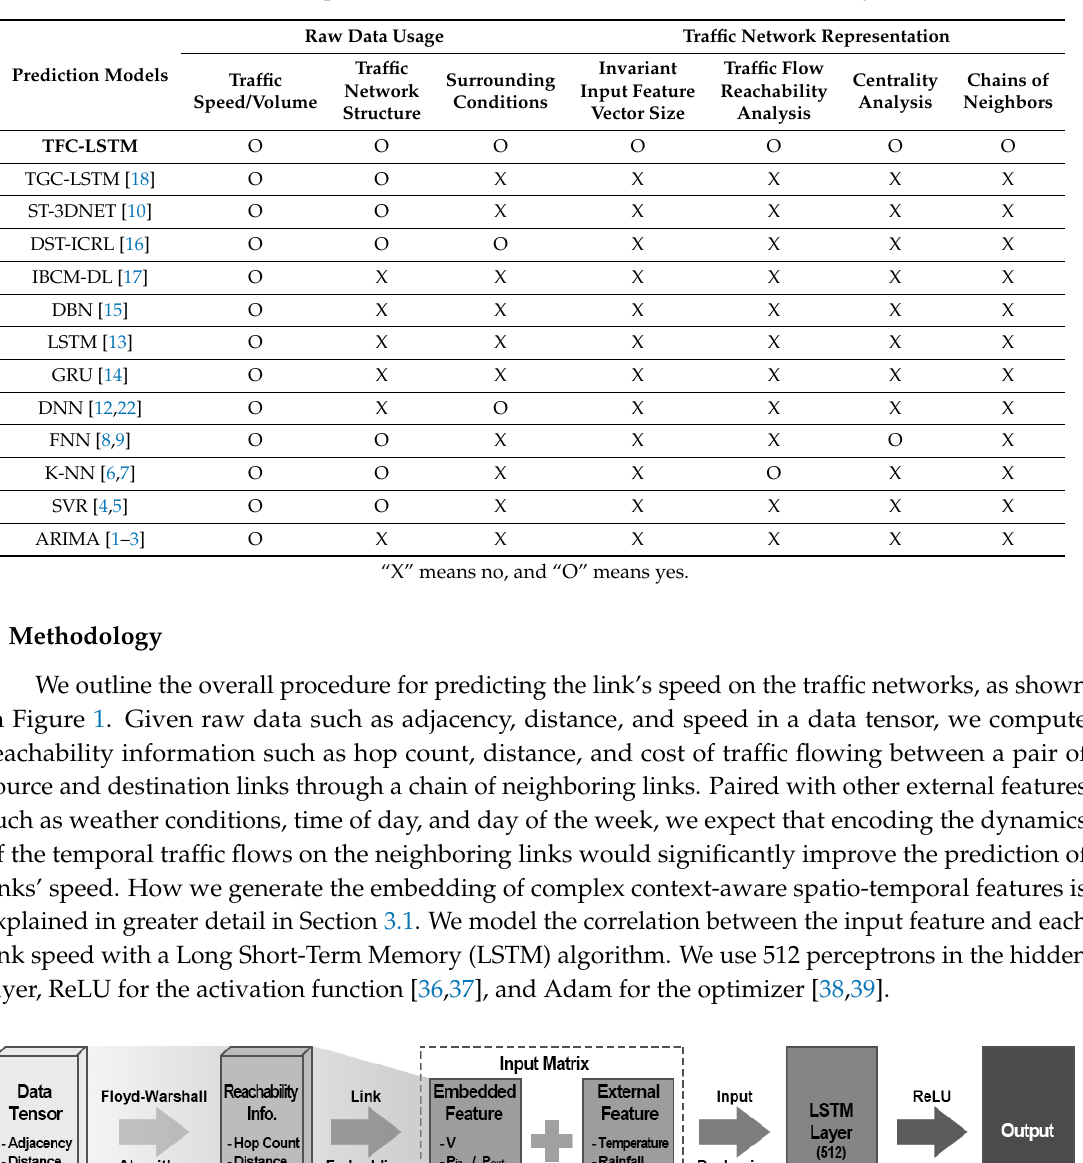
Table 1. Comparison with other models. TFC, Traffic Flow Centrality.